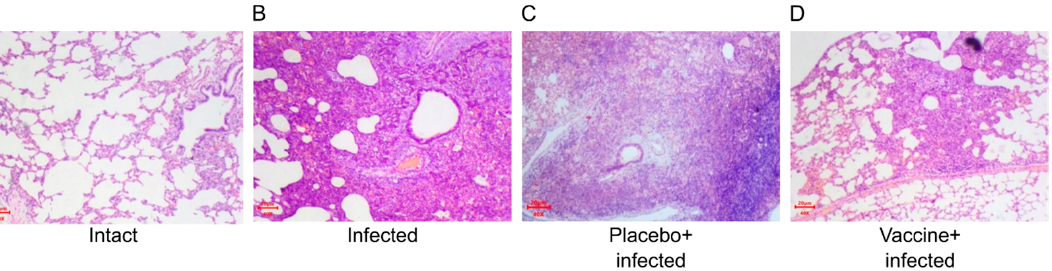
Figure 5. Representative examples of microscopic (magni fi cation 40×) lesions of SARS-CoV-2 in Syrian hamsters. ( A ) Intact animals’ group, ( B ) non-vaccinated and infected group, ( C ) placebo-treated and infected group, and ( D ) vaccinated and infected group. See also Figure S8.